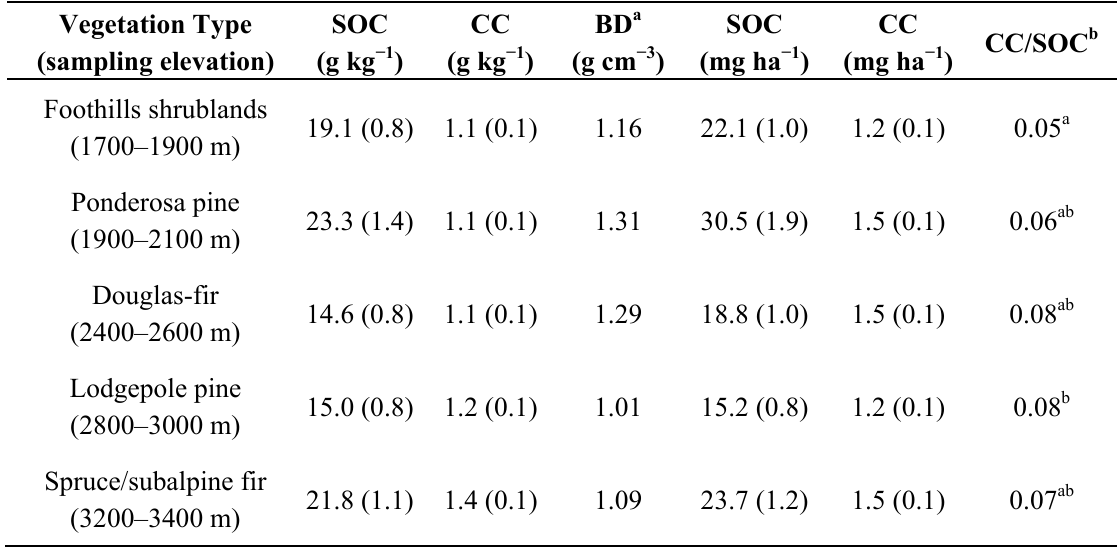
Table 1. Soil organic C (SOC), charcoal C (CC) and bulk density (BD) in upper 10 cm mineral soil for five vegetation types along an ecological gradient in the Colorado Front Range with +/ − 1 standard error in parentheses ( n = 10) and the CC/SOC